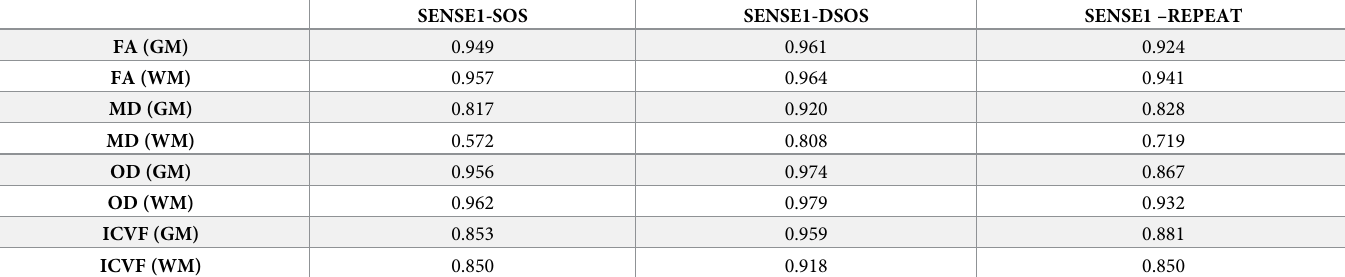
Table 2. Correlations of the tensor-based diffusion metrics (i.e., FA, MD) and NODDI-based diffusion metrics (i.e., OD, ICVF) between SENSE1-SoS, SENSE1-d- SoS, and SENSE1-SENSE1 repeat.